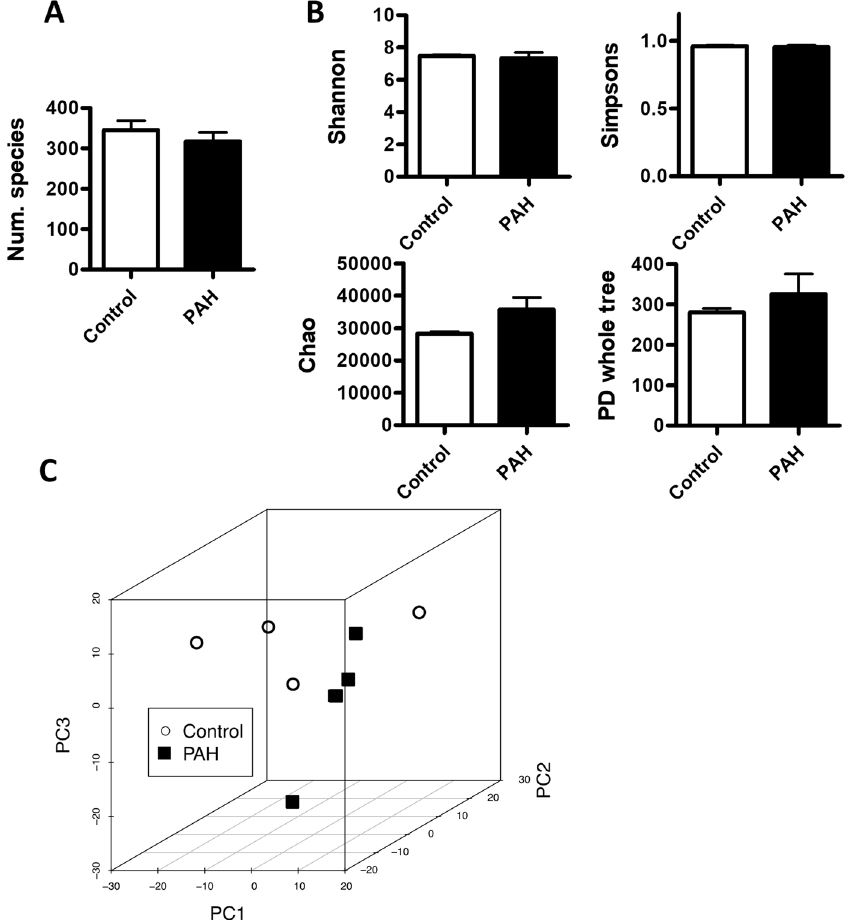
Figure 2. Microbial richness and diversity in PH and Principal Coordinate analysis (PCA). ( A ) Number of species identified. ( B ) α -diversity in rats in control and PAH rats measured by the Shannon, Chao, Simpsons and PD whole tree indexes. Results are means ± s.e.m. of 4 animals. ( C ) Unsupervised PCA were carried out to analyse the differences between control and PAH groups. Each principal component describes most of the variation between